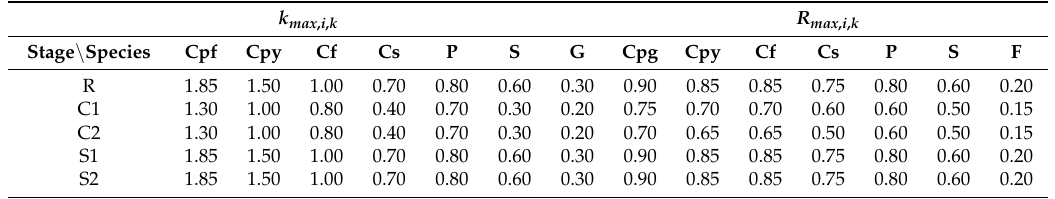
Table 2. Values of k max , i , k and R max , i , k for each stage and species in Equation (3). k max , i , k R max , i ,